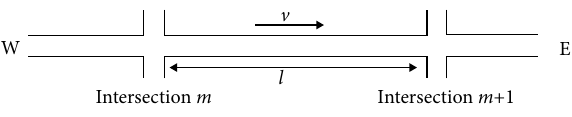
Figure 1: The adjacent